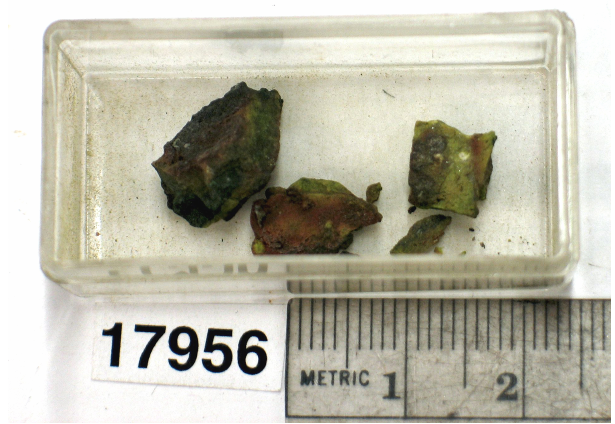
Figure 1. AMNH holotype specimen of johanngeorgenstadtite.